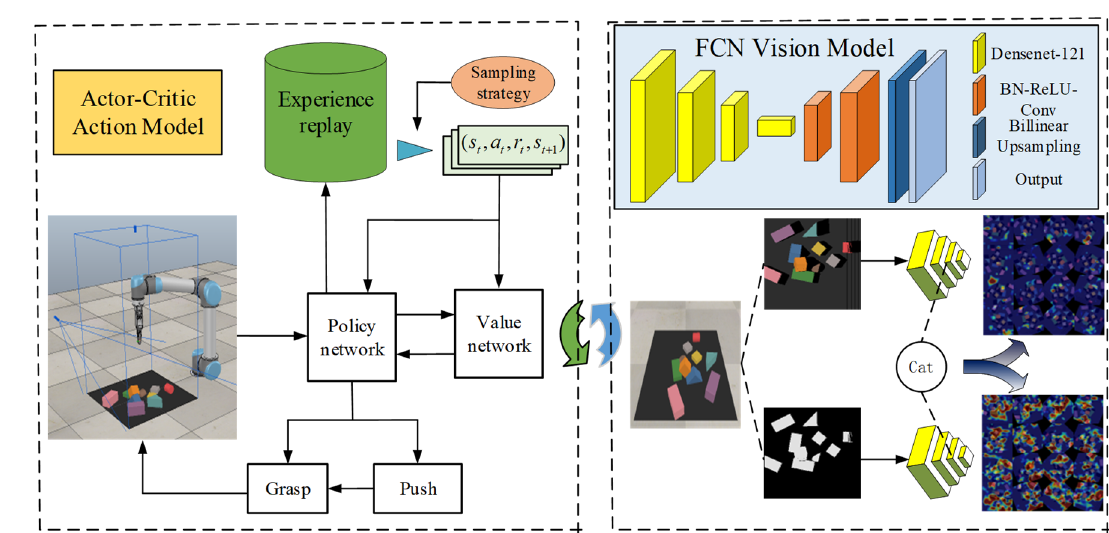
Figure 2. The framework of our system.